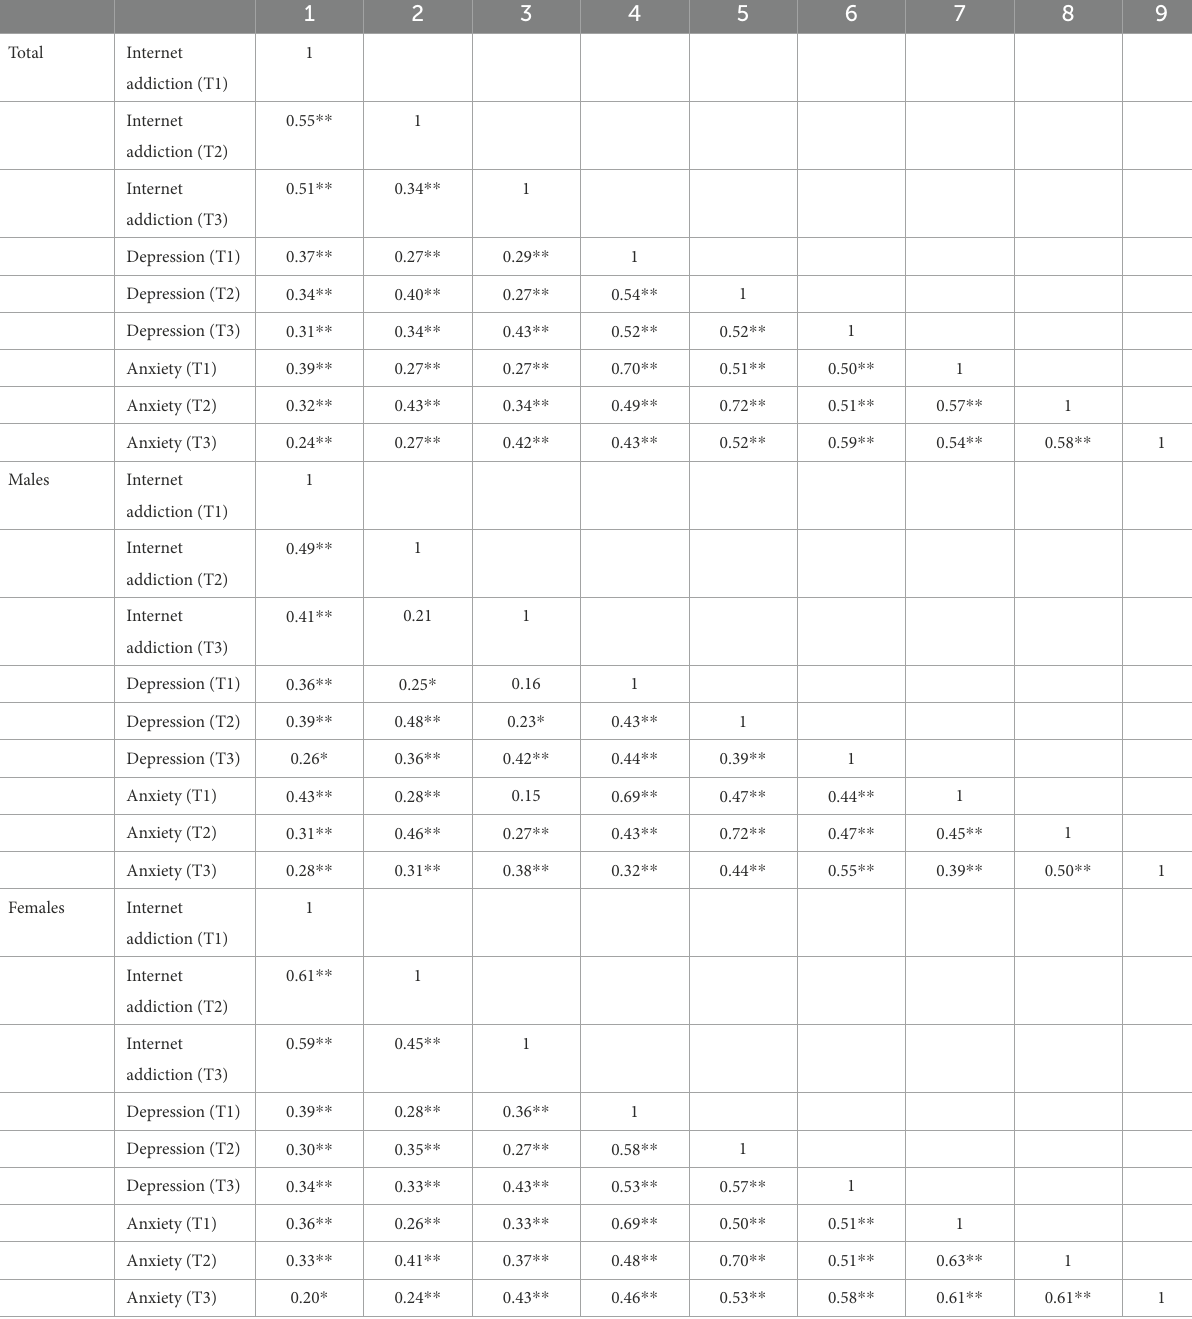
TABLE 3 Correlation analysis between depression, anxiety, and Internet addiction in the general, male, and female groups.